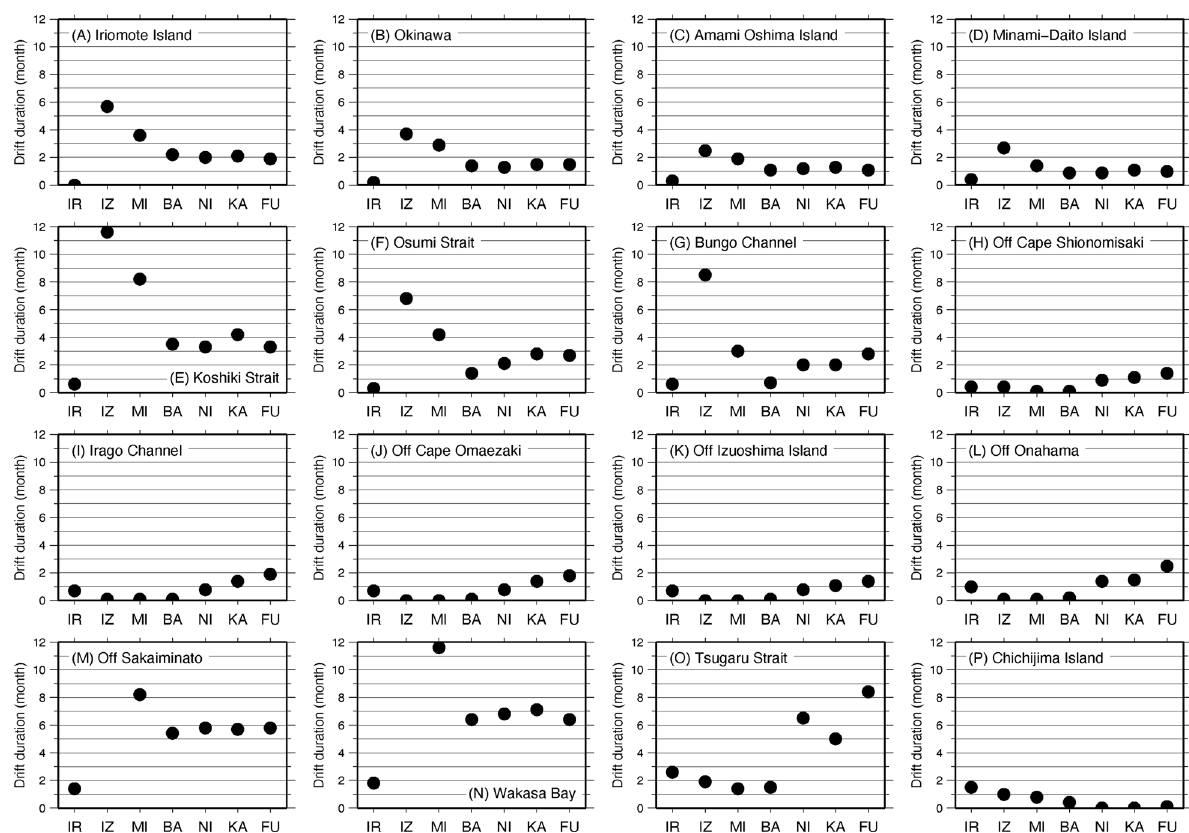
Fig. 8 The shortest drift durations of virtual pumice clasts that arrived at each target area from (V1) submarine volcano NNE of Iriomote Island (IR), (V2) Izu-Tobu volcanic range (IZ), (V3) Miyakejima (MI), (V4) Bayonnaise Rocks (BA), (V5) Nishinoshima (NI), (V6) Kaitoku Seamount (KA), and (V7) Fukutoku-Oka-no-Ba (FU) from 1982 to